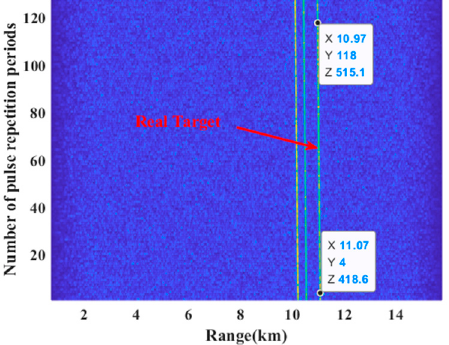
Figure 9. Pulse compression result of multi-period echo signal.